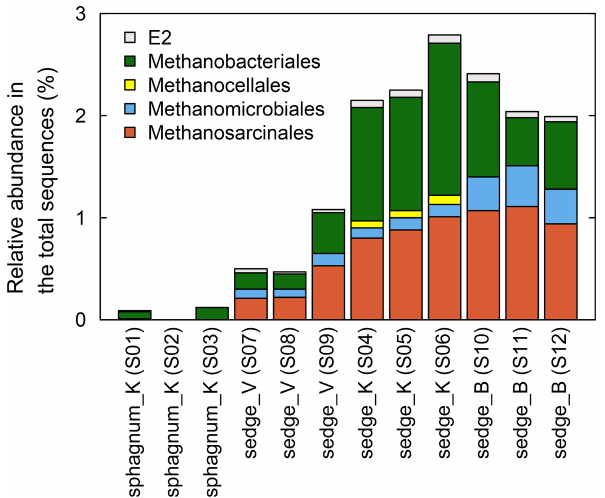
Figure 8. Phylogenetic compositions of methanogenic archaea by order in wet areas. Soil samples (organic layers) were taken in tripli- cate from 10cm in depth in each wet area in July 2016. See Table S5 for detailed results. permafrost fens (42–147 mg CH 4 m − 2 day − 1 ) in a database across permafrost zones compiled by Olefeldt et al. (2013).